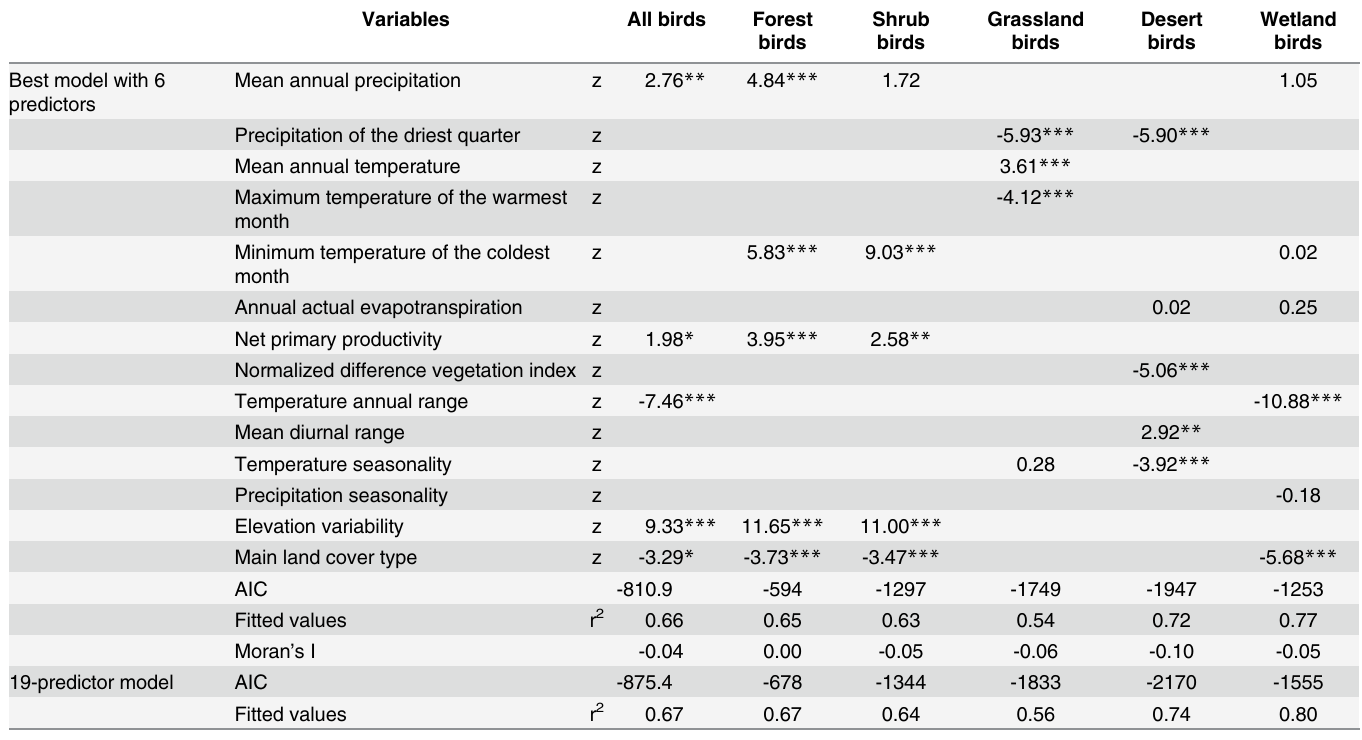
Table 3. SLM multivariate models for the residuals of species richness of all resident birds and its habitat groups. Variables All